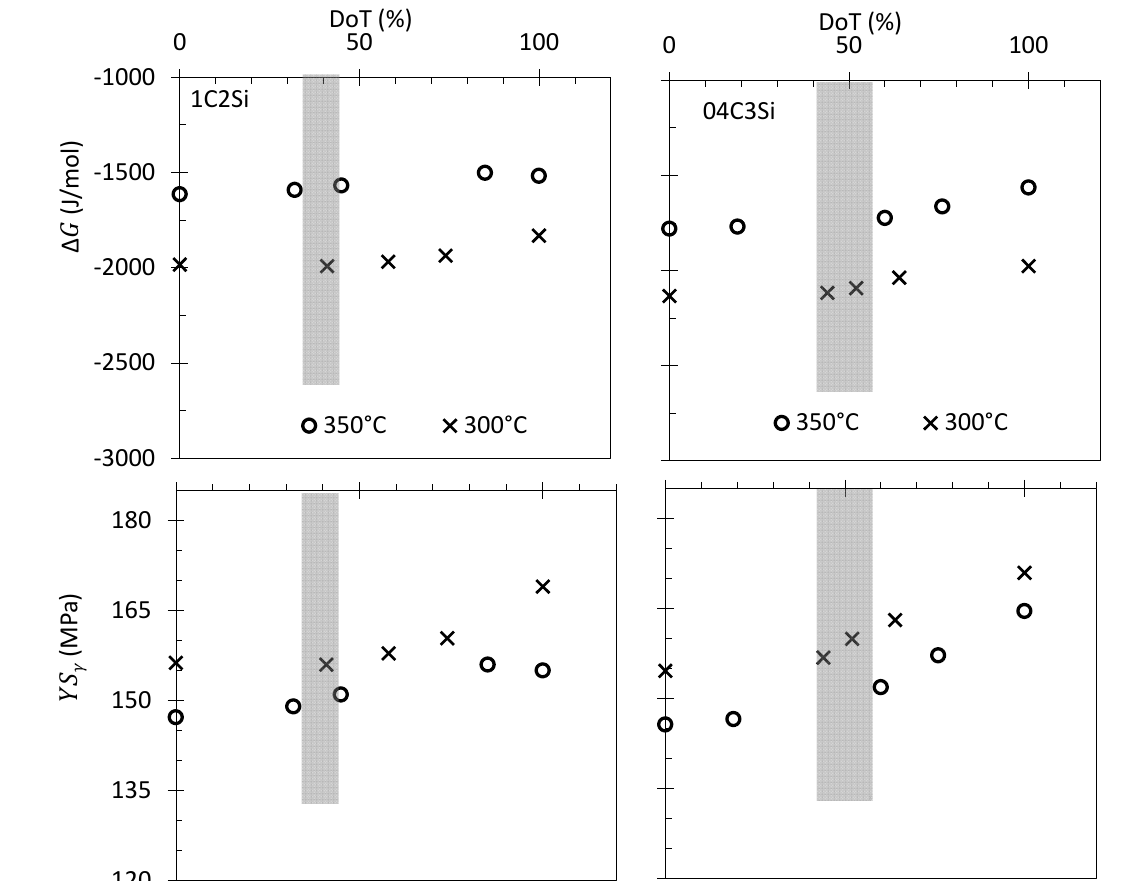
Figure 10. Variation of both the driving force for bainitic transformation ( ∆ G ) [27] and the YS γ [29] as a function of the degree of transformation (DoT). The shaded regions represent where the DRCL max is